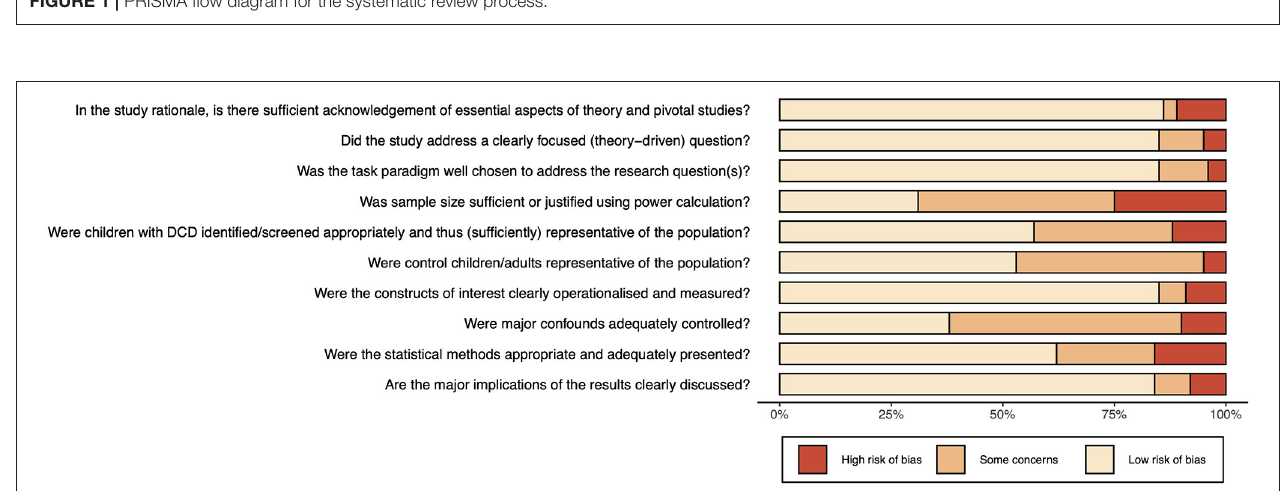
FIGURE 1 | PRISMA flow diagram for the systematic review process.